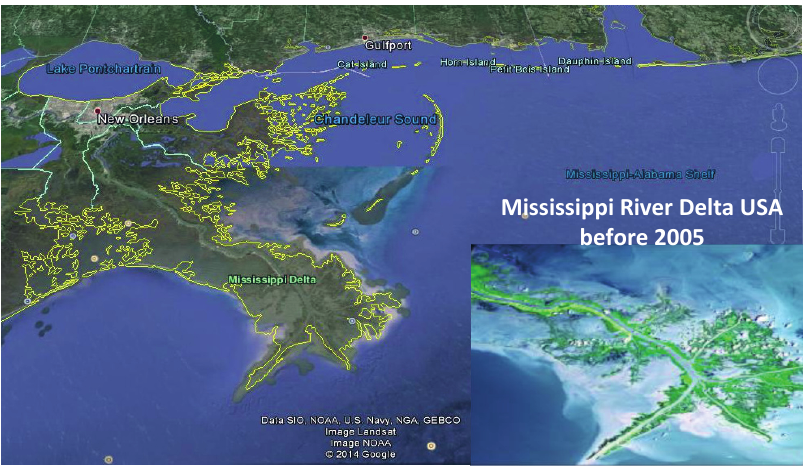
Figure 4. Map image of the Louisiana delta plain, Mississippi River delta, coastal barrier islands and wetlands, and New Orleans just south of Lake Pontchatrain (Google Earth